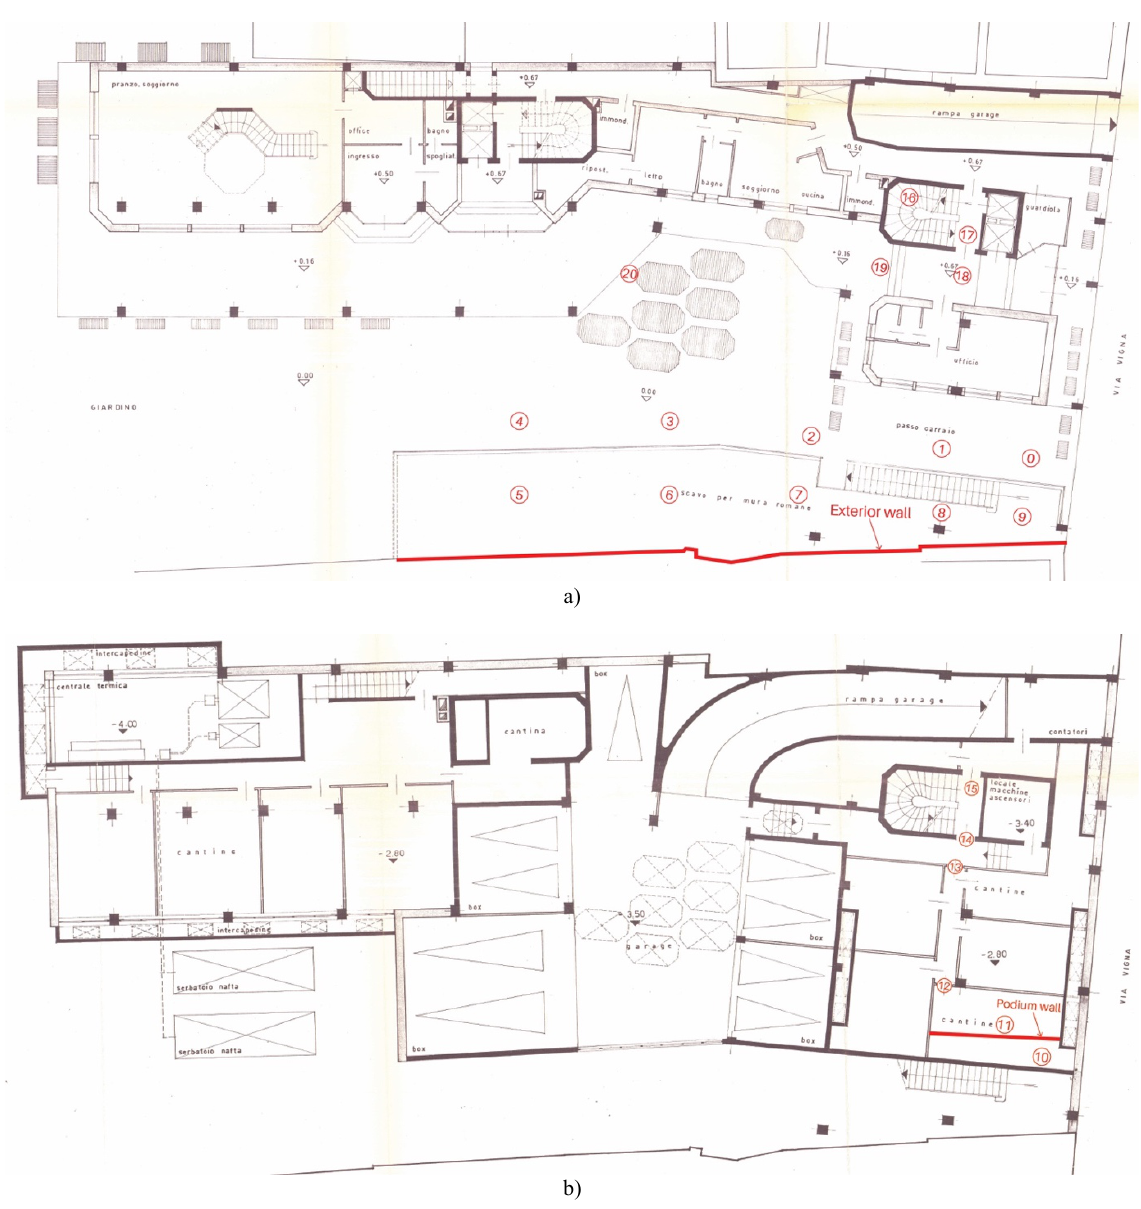
Figure 2. Laser scanner positioning for creating the point cloud represented in Figure 3: a) ground floor; b)